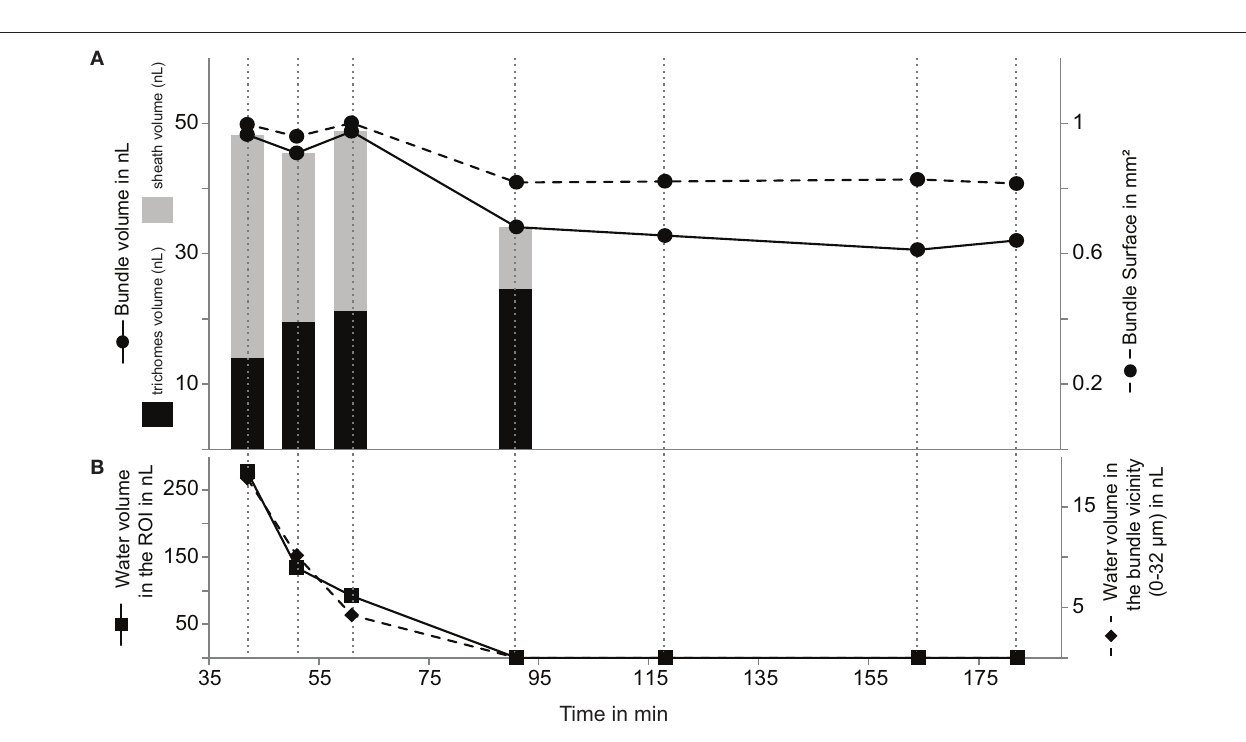
FIGURE 4 | Evolution of bundle volume and surface area (A) with decreasing local (0–32 µ m from the bundle surface) and total (entire ROI) water content (B) from 42 to 182min. The contribution of the trichomes (black) and sheath (gray) to the total bundle volume are plotted as bar plot for the first four time points (A) . a total increase of 75%) (Table S3). This suggests the intriguing of EPS decreased significantly (by 70%) between 42 and 91 min, possibility that a net water transfer occurred from the sheath from 34.3 to 14.0 nL. During the same period, however, the material to the trichomes during this period. This ratio volume of trichomes increased gradually from 9.5 to 24.6 nL (for